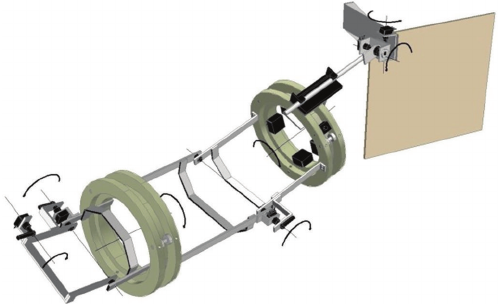
Figure 1: CAD diagram of the 6-DOF exoskeletal position sensing harness. The curved arrows show the axis of 7 axes of rotation (the 7th DOF is used to control the robotic gripper). The harness is worn around the human operator’s arm.